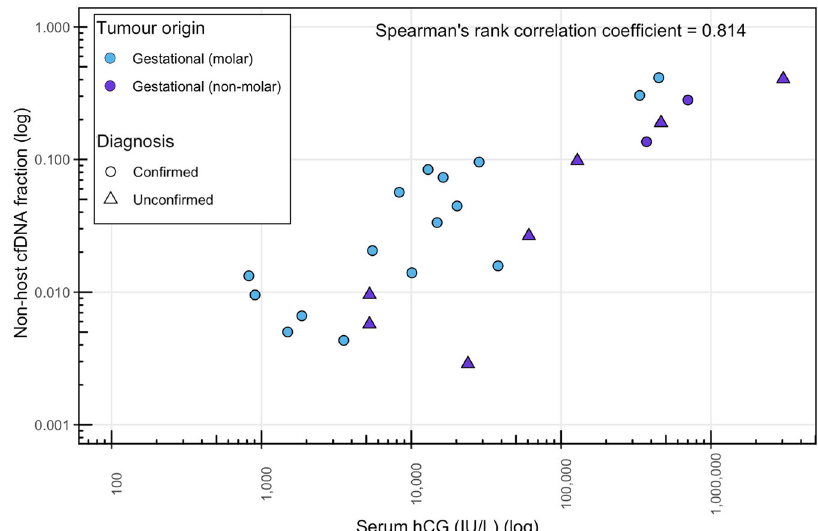
Fig. 4 Non-host allele fractions in cfDNA compared to serum hCG levels in gestational tumour cases. Non-host cfDNA fractions tend to be relatively higher in tumours originating from molar pregnancies than other pregnancies as they contain two paternally inherited genomes. Only samples with reliable estimates of cfDNA fraction (i.e. ≥ 12 SNPs with non-host alleles) were included. Con fi rmed = cases with a known gestational origin. Uncon fi rmed = cases with non-host cfDNA that did not have tissue available to con fi rm the